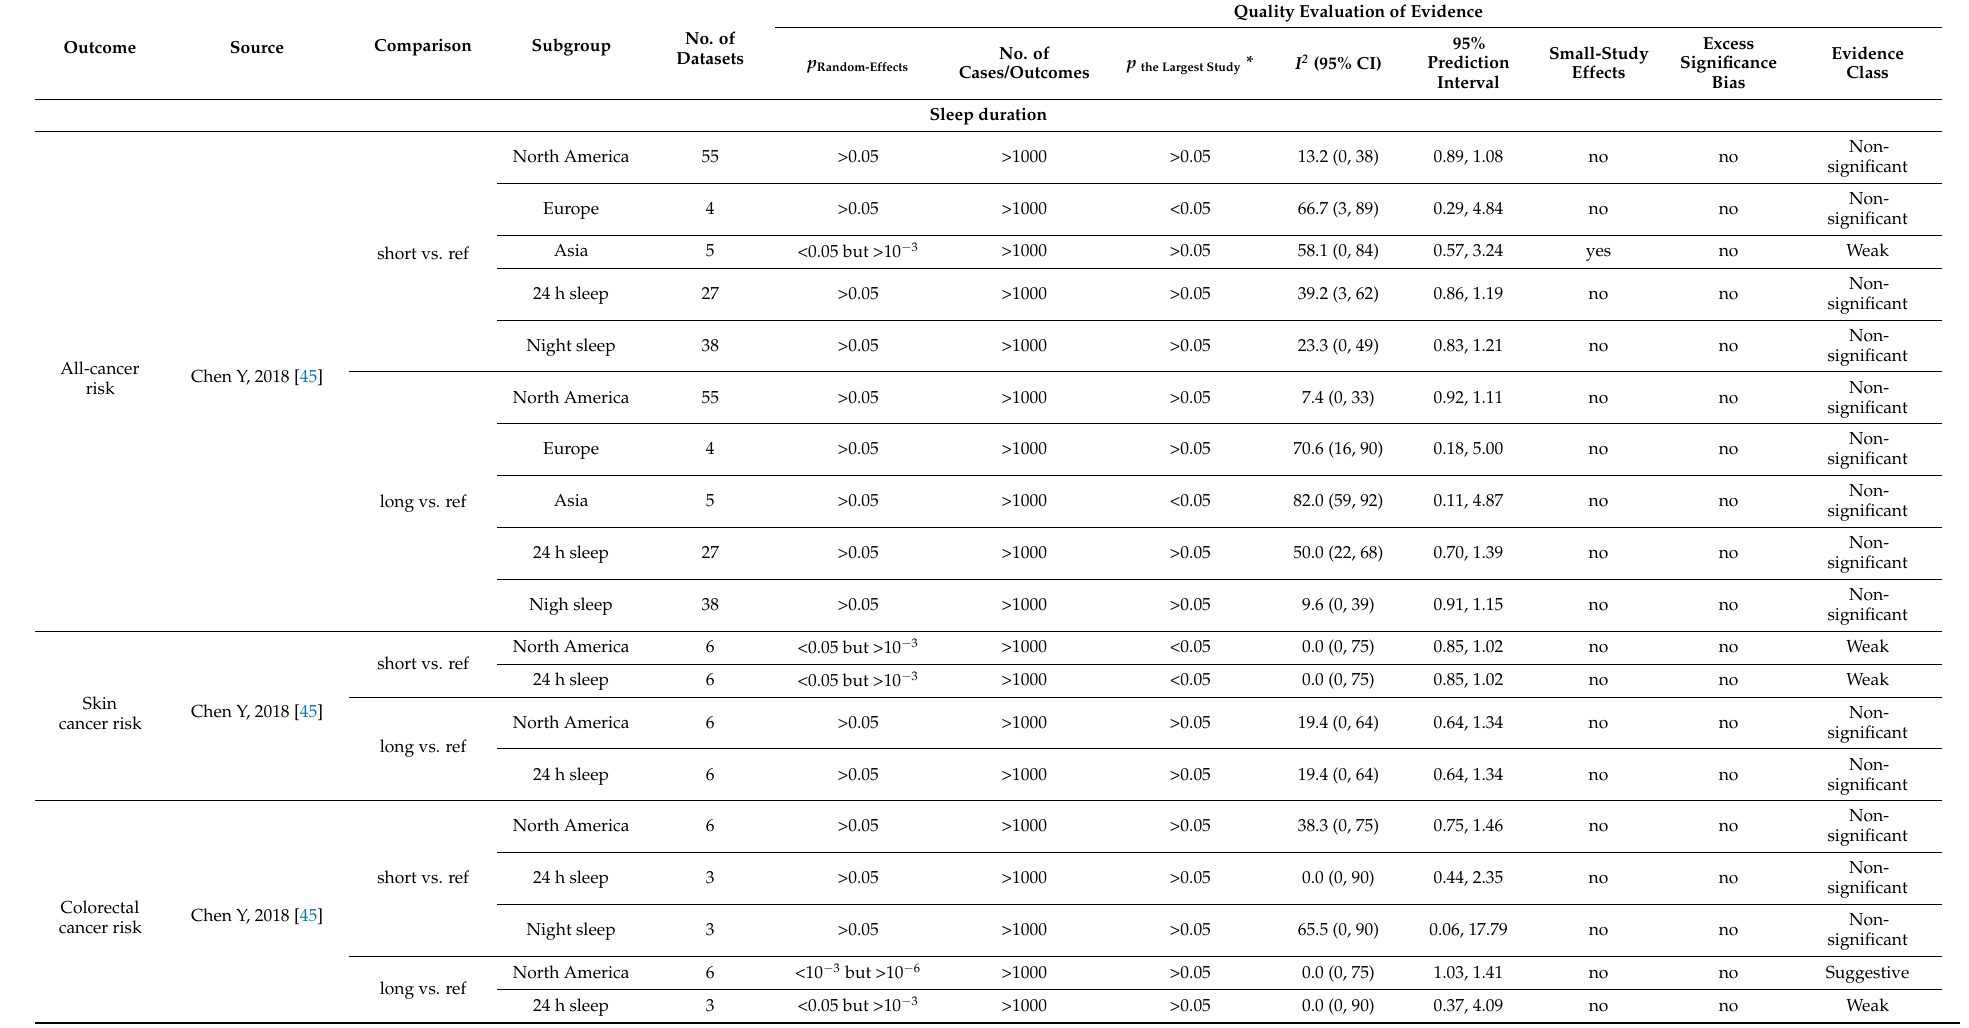
Table 3. Subgroup analysis for evidence evaluation on sleep characteristics and cancer-related